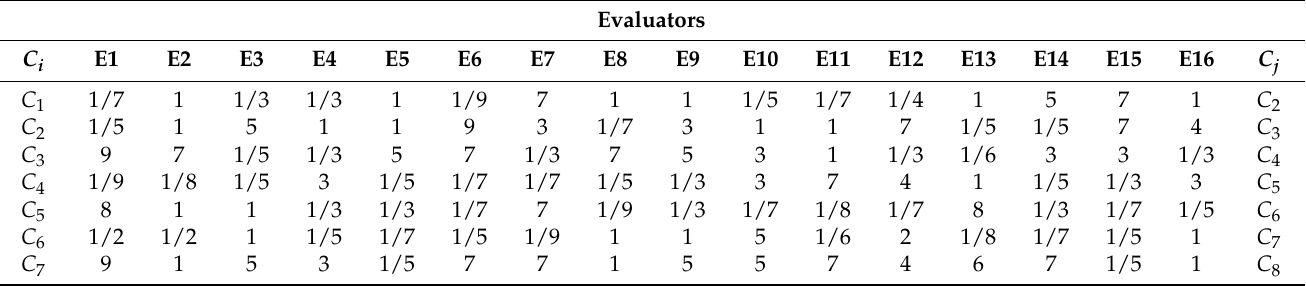
Table 2. Preference relation matrix for pairwise comparison of the criteria.